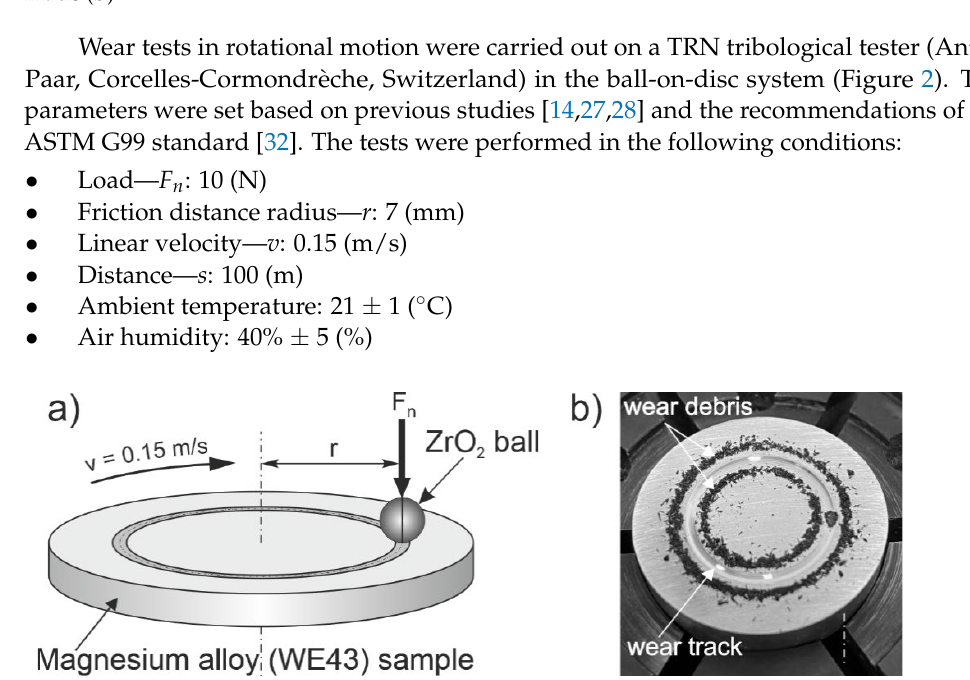
Figure 1. Performing an indentation measurement ( a ) ; microscopic observation of the indents made ( b ).